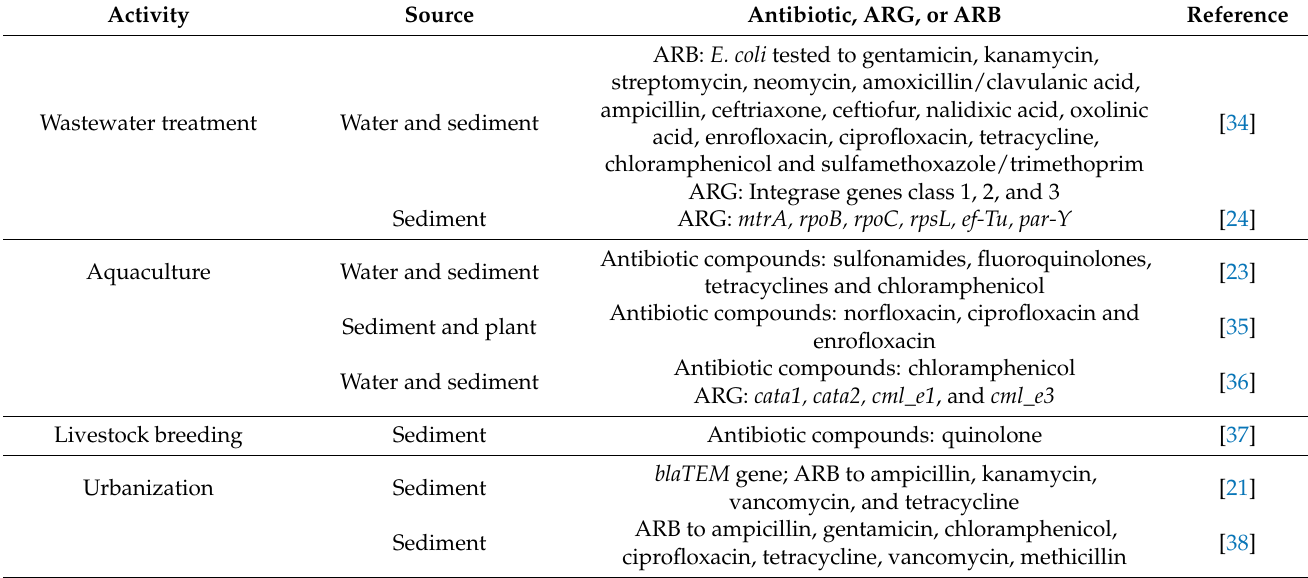
Table 1. Recent studies (2015–2020) on the relation between anthropogenic activities and presence of antibiotics, antibiotic resistance genes (ARGs), and antibiotic-resistant bacteria (ARB) in